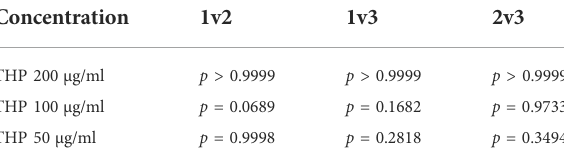
TABLE 1 p values of the cell activity among the fi rst three groups of different THP concentrations (1: control group; 2: magnetic fi eld group; and 3: magnetic fi eld + Fe 3 O 4 -CS/GP